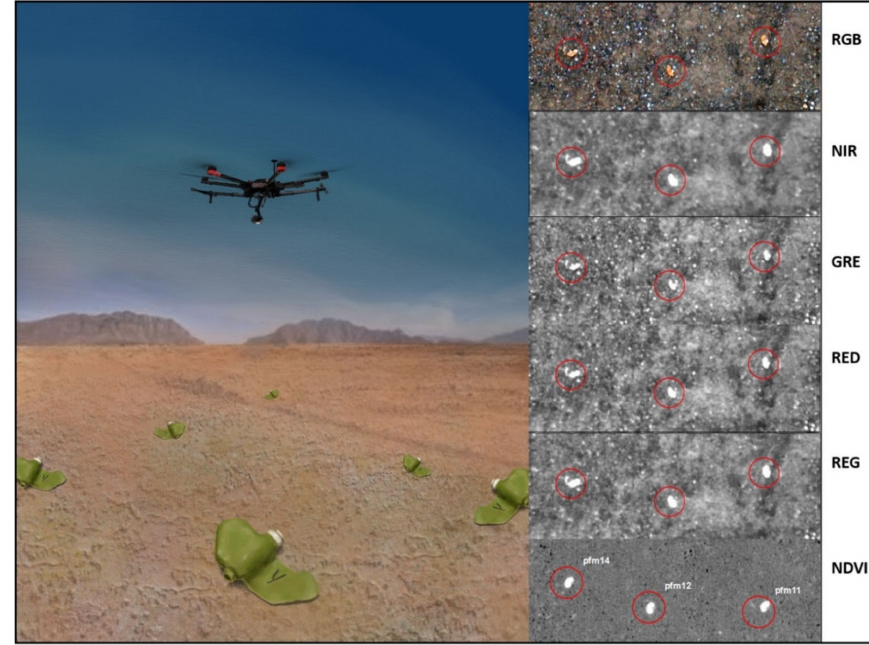
Figure 4. Illustration of experimental design mid-flight in Afghani terrain, using the Parrot Sequoia multispectral sensor attached to the Matrice 600 Pro UAV (unmanned aerial vehicle). Processed multispectral images of the PFM-1 taken from 10 m height during